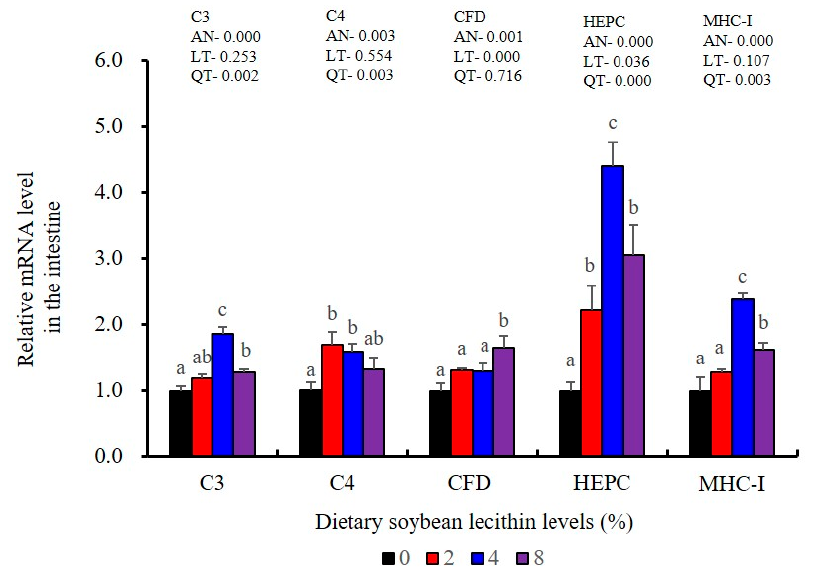
Figure 10. Effect of dietary soybean lecithin on relative gene expression levels of immune-related factors in the intestine of juvenile largemouth bass. Bars with different letters indicate significant differences ( p < 0.05), while that with the same letter or no letter superscripts indicate no significant differences ( p > 0.05), AN: ANOVA, LT: linear trend, QT: quadratic trend.